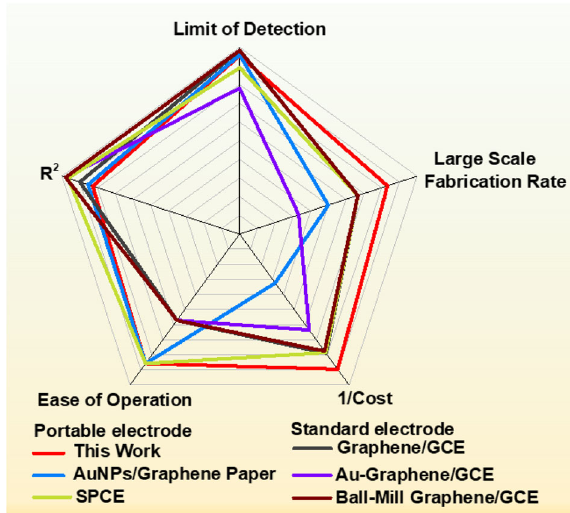
Fig. 6 Comparison of CF/GO/Cellulose paper - based sensors with other sensors. Radar chart compares the manufacturability and performance of CF/GO/Cellulose paper-based electrochemical sen- sor with sensors from other studies 23,31 – 37